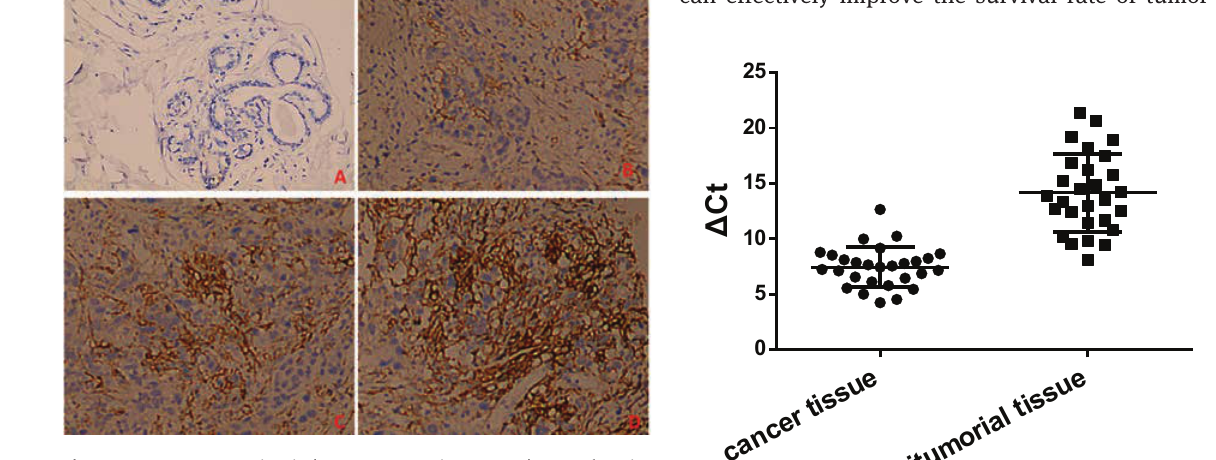
Figure 1 : PD-L1 expression in breast cancer tissues and normal peri- tumorial tissues. (A: PD-L1 negatively expressed in normal breast tissues; B: PD-L1 lowly expressed in infiltrating ductal carcinoma tissues; C: PD-L1 highly expressed in infiltrating ductal carcinoma tissues) ×20.